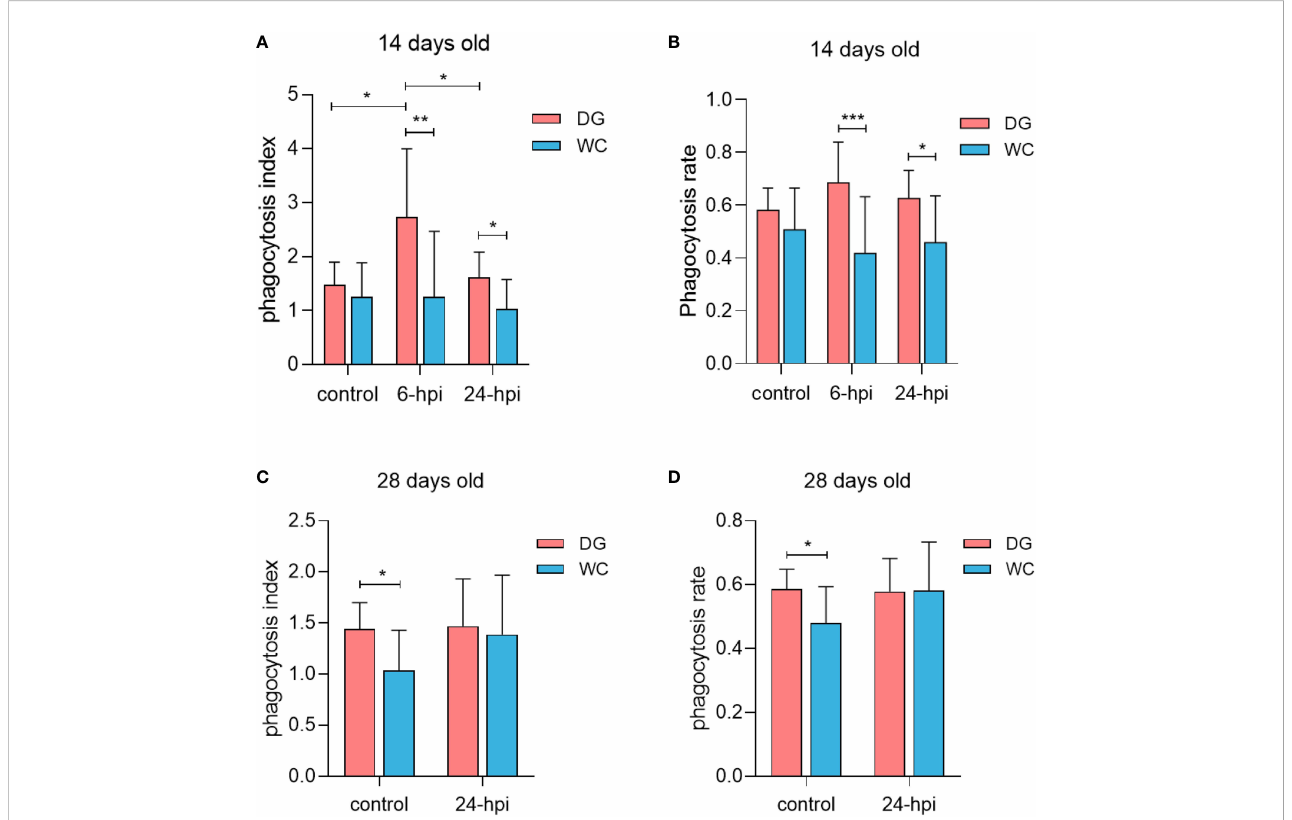
FIGURE 2 Stronger phagocytic ability of macrophages in Dagu chickens. Detection of phagocytic ability after isolation of peripheral blood macrophages in two breeds of chickens of different ages with or without Salmonella infection. (A) Comparison of phagocytosis index differences at 14 days old (n=8~14 per group); (B) Comparison of phagocytosis rate differences at 14 days old (n=8~14 per group); (C) Comparison of phagocytosis index differences at 28 days old (n=10~12 per group); (D) Comparison of phagocytosis rate differences at 28 days old (n=10~12 per group). P < 0.05 (*), P < 0.01 (**) or P < 0.001